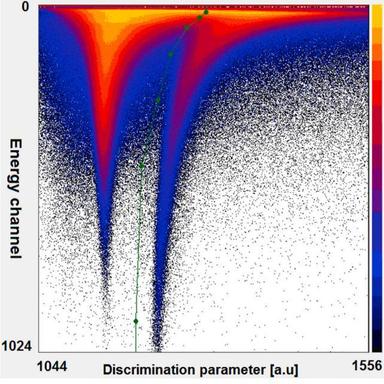
Characteristics of evaluation of signal. The figure shows neutron/ gamma discrimination - the left peak is the gamma peak (lower discrimination parameter), and the right peak is the neutron peak.